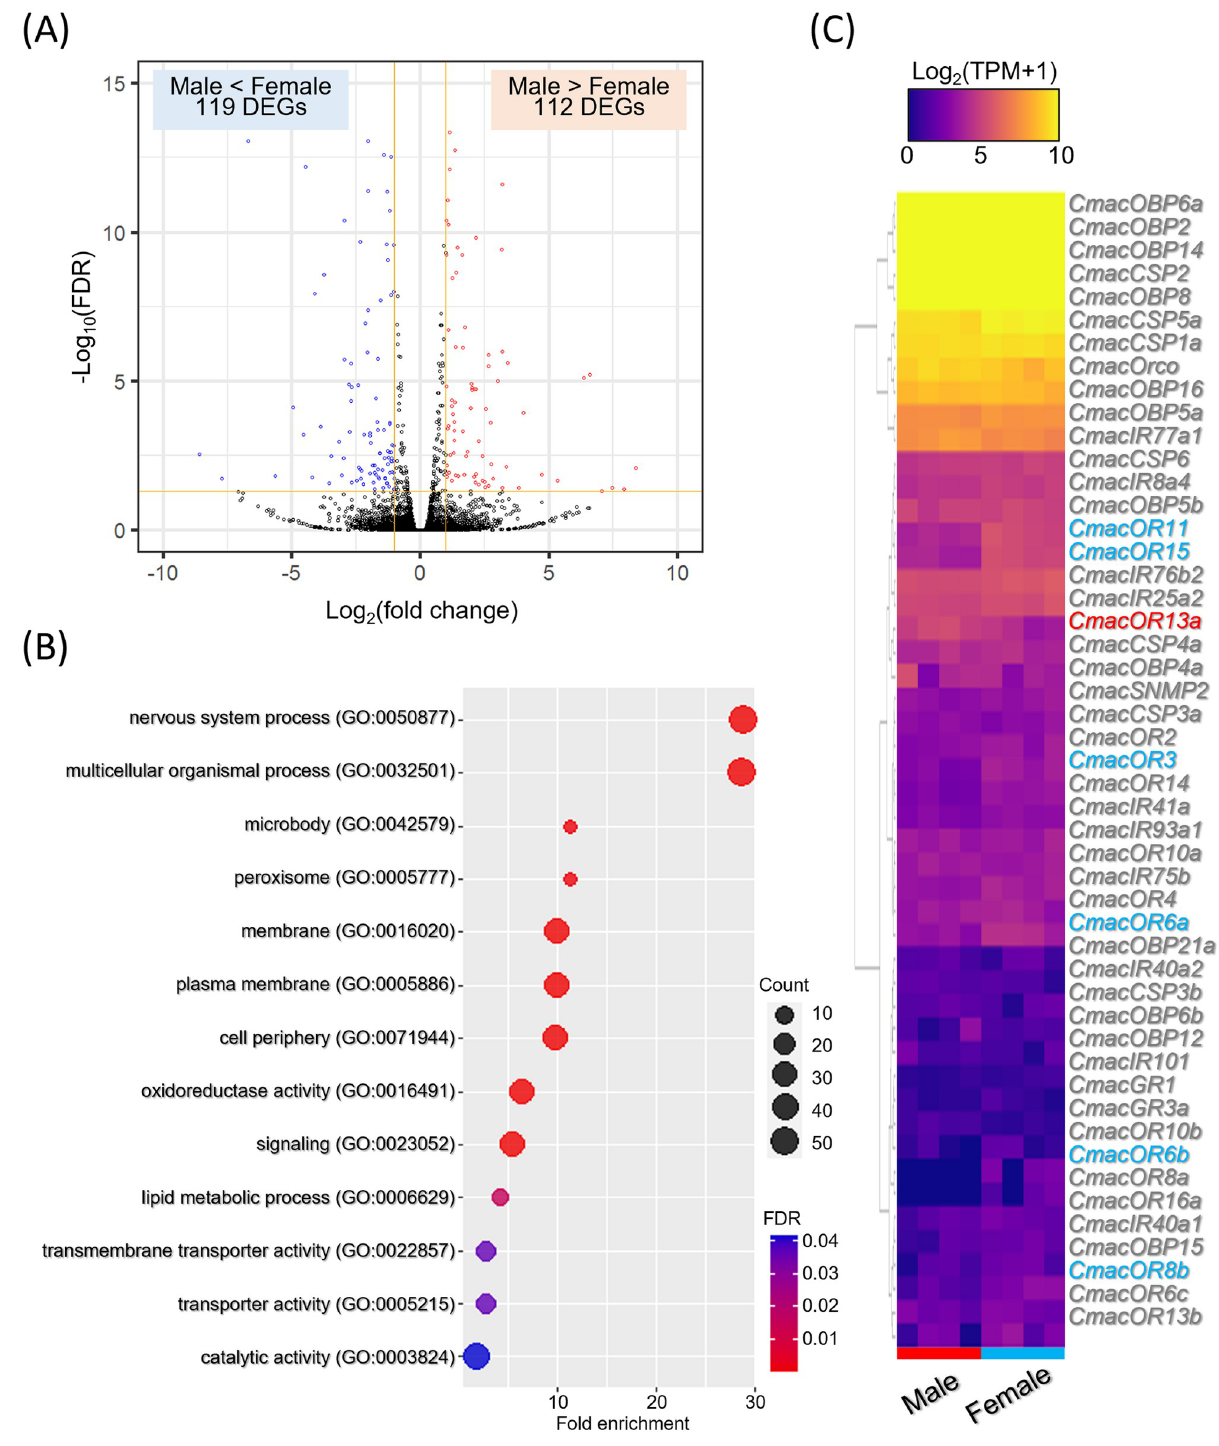
Fig 7. Differential gene expression between antennae of virgin males and females. (A) Volcano plot showing log2 fold change (FC) ( x -axis) and log10 false discovery rate (FDR) ( y -axis) plots of all expressed unigenes. The red plots represent the 112 upregulated DEGs (males > females) (FC � 2 and FDR < 0.05), whereas the blue plots represent the 119 downregulated DEGs (males < females) (FC � 2 and FDR < 0.05). (B) Dot plot showing fold enrichment, gene scale, and FDR derived from GO enrichment analysis. (C) Heatmap showing the 49 olfactory-related chemosensory gene expression profiling through de novo antennal RNA-seq. CmacOR13a in red and the six CmacORs in blue are shown as up- and downregulated DEGs, respectively.